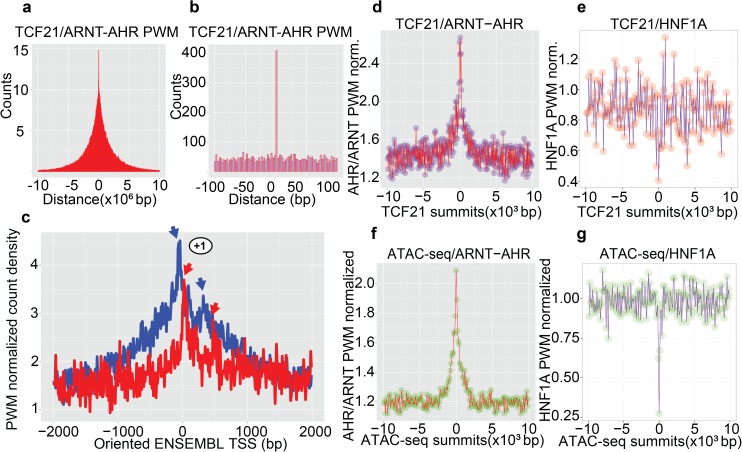
Genome-wide correlation of TCF21 and AHR-ARNT position weight matrices (PWMs).(a) Distribution of distances from the center of AHR-ARNT predicted sites to the closest TCF12/TCF21 predicted site in +/-50kb genomic intervals. TCF12/TCF21 (MA0521.1) and AHR-ARNT (MA0006.1) matrices were obtained from the JASPAR database. (b) Distribution of distances from AHR-ARNT predicted sites to the closest TCF12/TCF21 predicted site in +/-100bp window from the center of the AHR-ARNT sites. The graph shows over 400 overlapping TCF12/TCF21 and AHR-ARNT sites. (c) Genome wide spatial relationship between AHR/ARNT and TCF12/TCF21 PWMs are graphed, and co-localize near transcription start sites (TSSs). Co-localization of AHR/ARNT and TCF12/TCF21 predicted binding sites over oriented ENSEMBL promoters reveals longitudinal phasing of the two matrices with peaks immediately after the transcription start site and also after the +1 nucleosome (arrows). Predicted sites were counted in a window of 10bp and normalized globally to the average number of sites in 10bp windows. (d) Co-localization of AHR/ARNT predicted binding sites and TCF21 ChIP-seq summits is shown as a density plot. Predicted sites were counted in a window of 100bp and normalized globally to the average number of AHR/ARNT sites in 100bp windows. (e) Absence of genome wide correlation between negative control matrix for HNF1A (MA0046.1) and TCF21 summits in HCASMC. Localization of HNF1A predicted binding sites and TCF21 ChIP-seq summits is shown as a density plot. Predicted sites were counted in a window of 100bp and normalized globally to the average number of HNF1A sites in 100bp windows. (f) The genome wide correlation between AHR/ARNT binding sites and open chromatin is shown for HCASMC. Co-localization of AHR/ARNT predicted binding sites and open chromatin ATAC-seq summits is shown as a density plot. (g) The lack of correlation between control HNF1A PWM and open chromatin is shown for HCASMC. Localization of HNF1A predicted binding sites and open chromatin ATAC-seq summits is shown as a density plot.